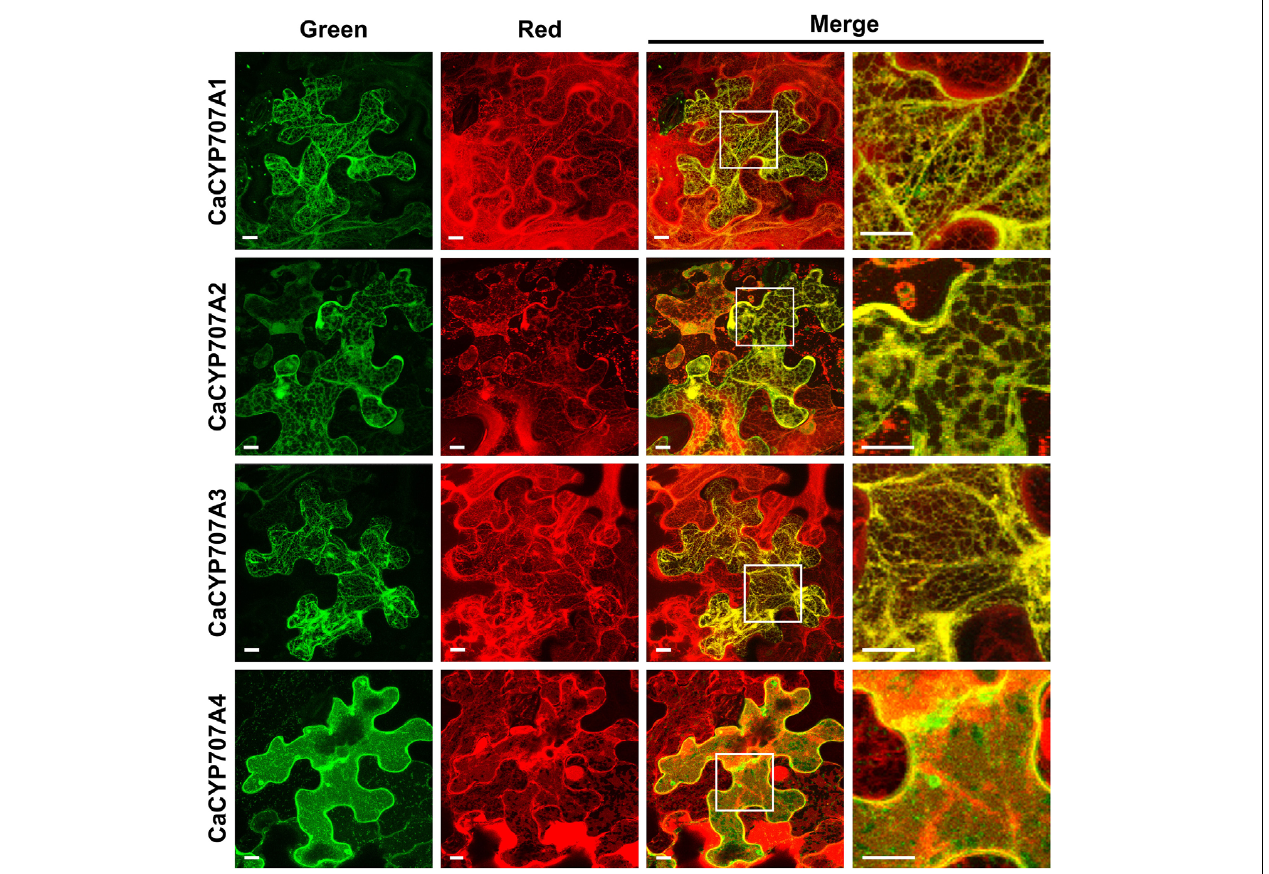
FIGURE 1 | Subcellular localization of CaCYP707As. Subcellular localization of CaCYP707A1, 2, 3, and 4 proteins fused to GFP was investigated by visualizing fluorescent signals. ER-specific localization of CaCYP707A1, 2, and 3 proteins and PM-specific localization of CaCYP707A4 was verified through co-localization of ER-targeting mCherry (ER-mCherry) and PM-targeting mCherry (PM-mCherry), respectively. CYP707A1, 2, 3, and 4 indicate tobacco transiently expressing 35S:CaCYP707A1-GFP , 2-GFP , 3-GFP , and 4-GFP . Green and red indicate fluorescence signals of GFP and mCherry, respectively. Scale bars = 10 µ m. More than three individuals of the indicated plants were analyzed, and the experiments were performed three times with similar